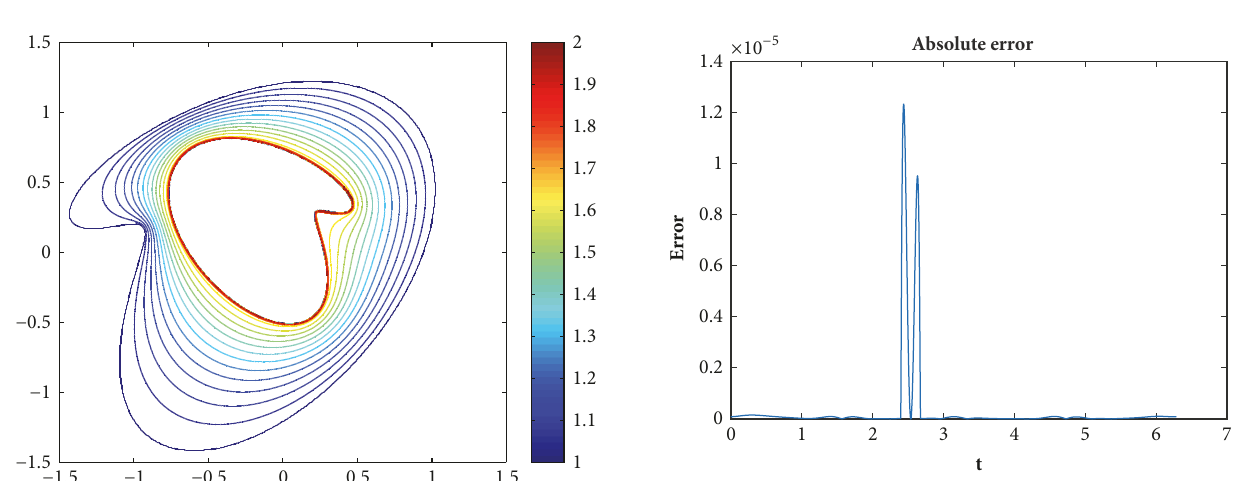
Figure1:Thecontourplotoftheapproximatesolutionwithconstant boundary conditions in Example 1.